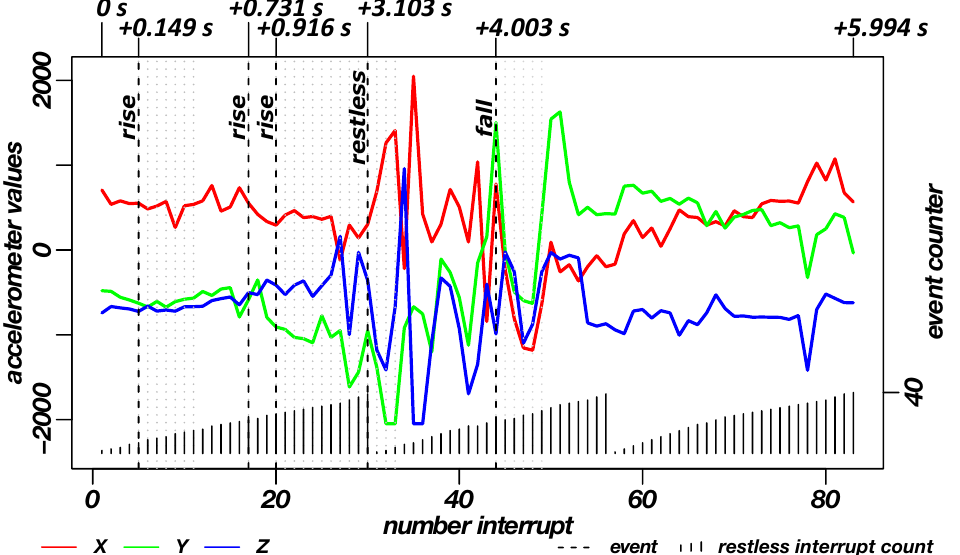
Figure 16. Diagram of the recorded data of the INBED wearables during a rising measurement on the subject. By means of the red-green-blue graphs, the recorded raw triaxial acceleration data of the sensor node can be seen for each interrupt of the wearable. Plotted in the lower area is the restlessness counter state, which counts up to the threshold of 40. A dashed line shows the triggering of the alarms (restlessness and uprising) in the diagram. For the rise event after the triggered alarm grey dotted lines are plotted to represent the standing. For the fall event after the triggered fall alarm light grey dotted lines are plotted to represent the further high/low-g interrupts. In the upper part the time interval of different milestones to the first interrupt is